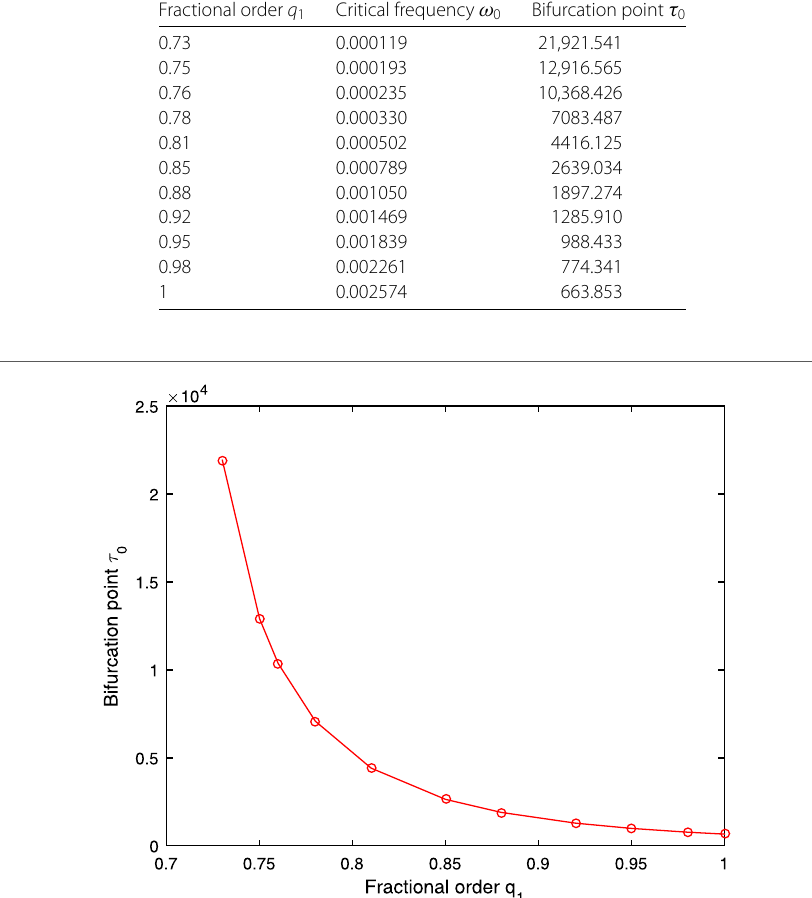
point τ 0 as q 1 is changed. The obtained values of ω 0 , τ 0 are described in Table 4. It can